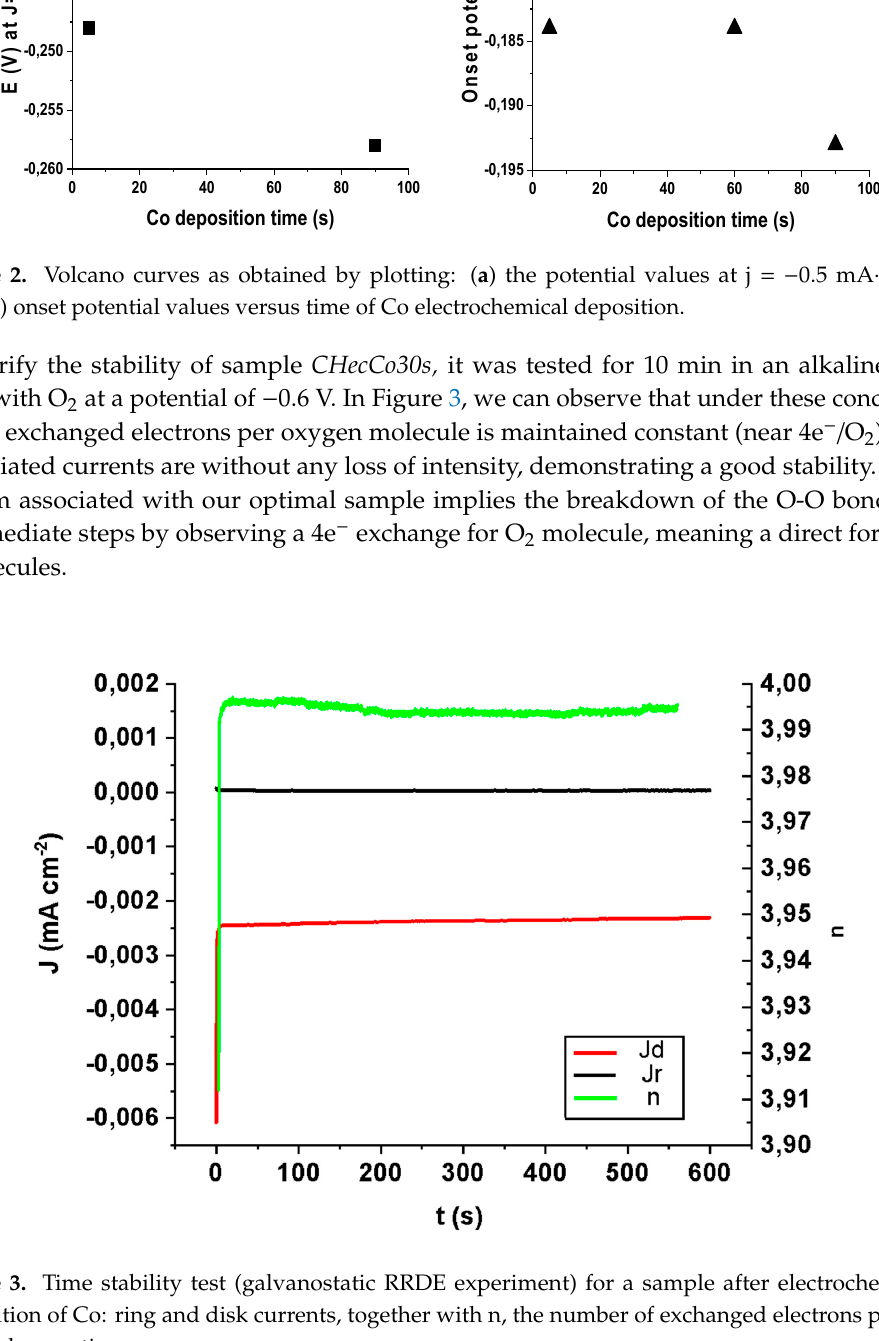
Figure 3. Time stability test (galvanostatic RRDE experiment) for a sample after electrochemical deposition of Co: ring and disk currents, together with n, the number of exchanged electrons per O 2 molecule over time.